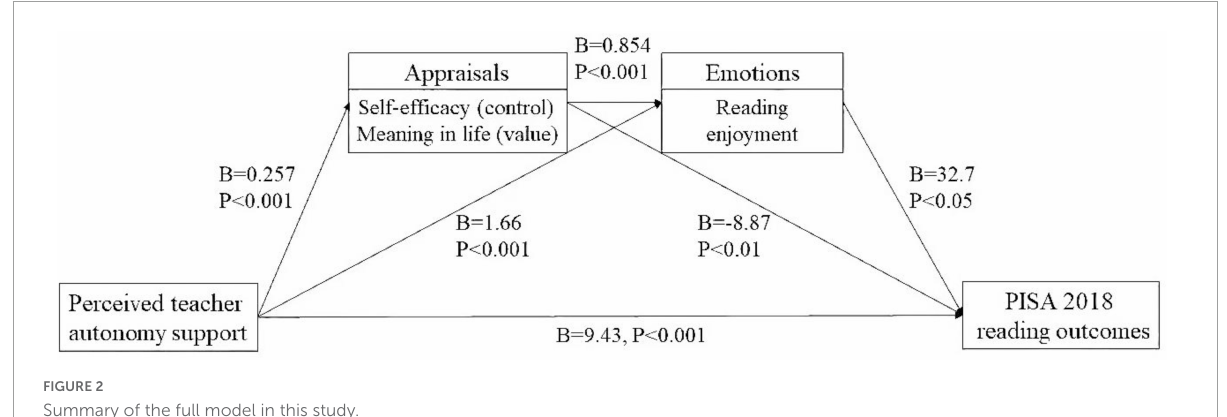
FIGURE2 Summary of the full model in this